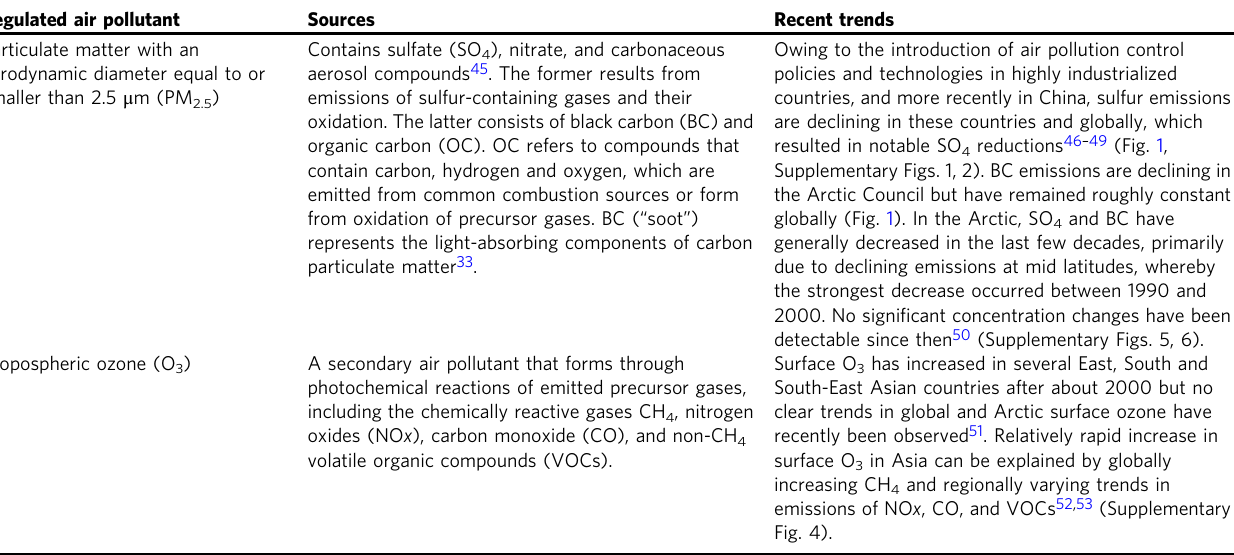
Table 1 Key air pollutants which act as Short-Lived Climate Forcers, their sources, and